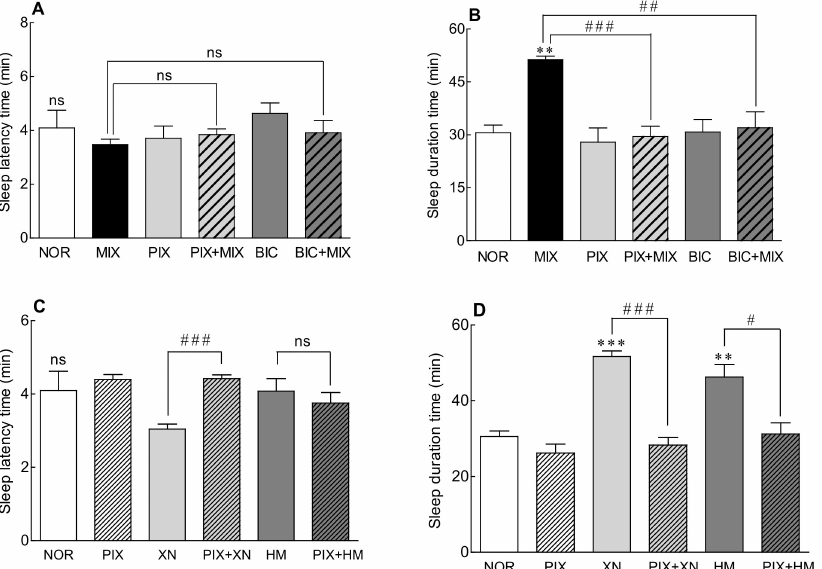
Figure 5. Effects of the GABA A receptor antagonist on the sleep latency time ( A , C ) and total sleep time ( B , D ) in mice that received a hypnotic dose of pentobarbital (42 mg/kg, i.p.). NOR: the 0.9% NaCl (physiological saline) group (normal control), MIX (Saaz:Saphir = 75:25, 150 mg/kg), PIX (4 mg/kg), and BIC (6 mg/kg). Values are presented as the mean ± standard error of the mean (SEM) for each group, n = 7. Asterisks indicate significant differences: ** p < 0.01 and *** p < 0.001 vs. NOR and # p < 0.05, ## p < 0.01, and ### p < 0.001 between the antagonist treatment and non-antagonist treatment (MIX group) by Tukey’s multiple comparison test. NOR, normal; MIX, mixture; PIX, picrotoxin; BIC, bicuculline; XN, xanthohumol; HM, humulone; and ns, not